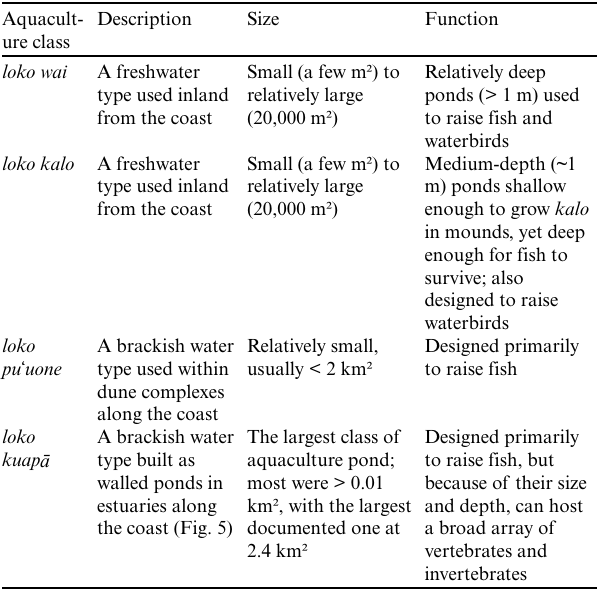
Table 2. The classes of aquaculture technologies ( loko ) developed in Hawaiian social-ecological systems to increase the abundance of key resource species. Compiled from Maly and Maly (2003 b